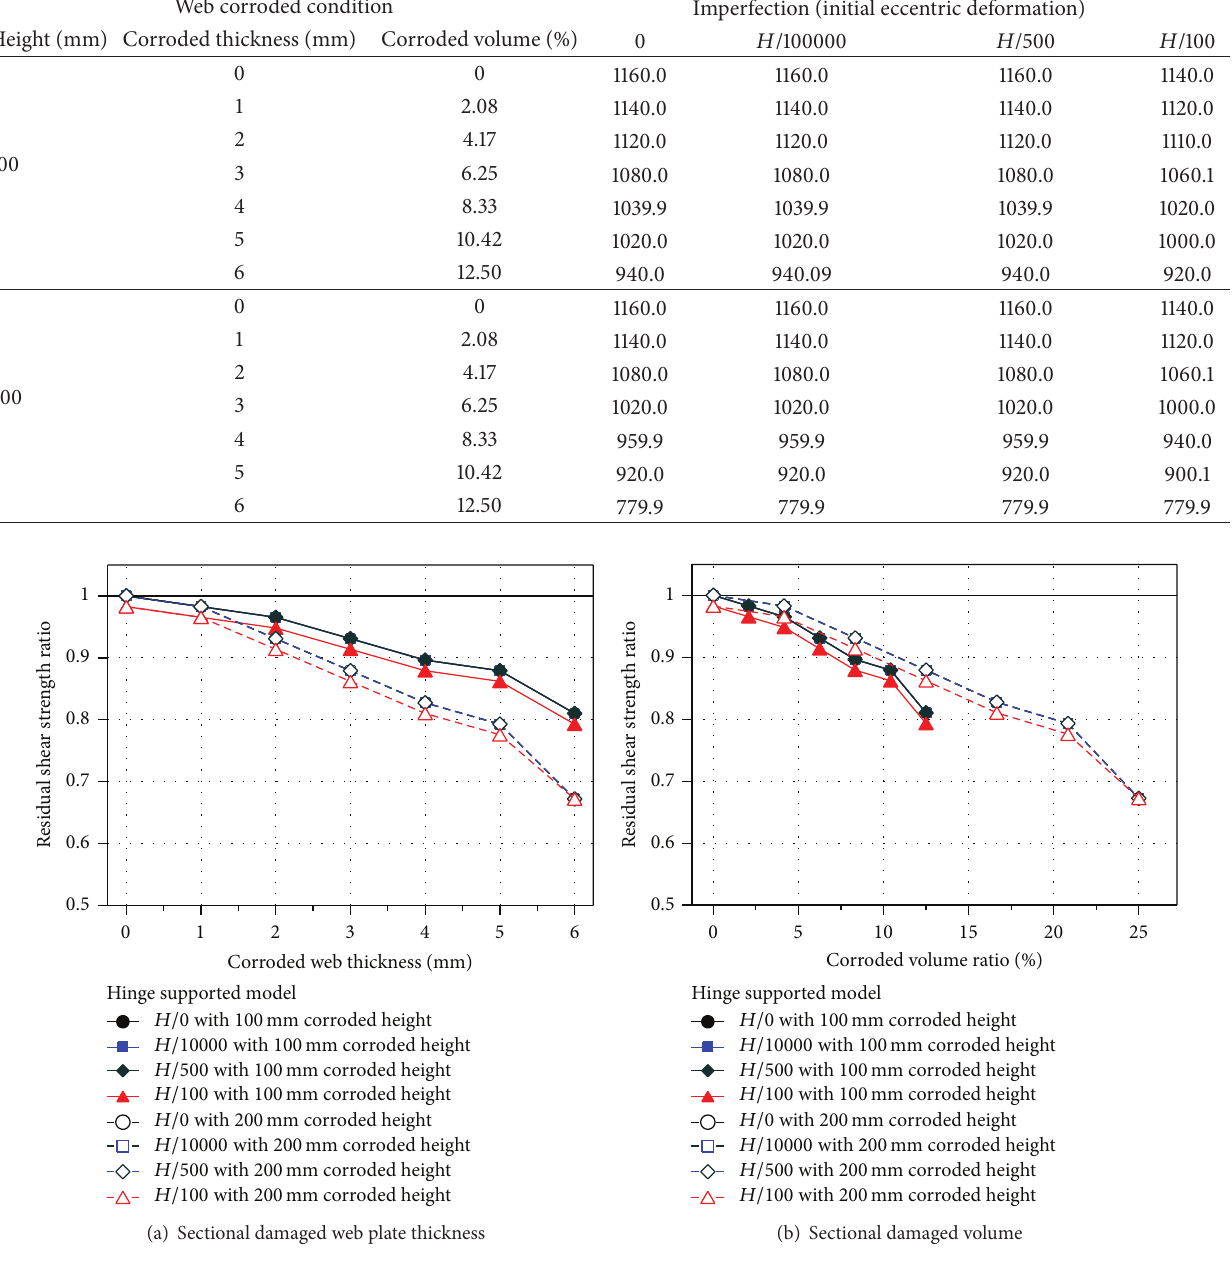
Figure 7: Shear buckling resistance ratios with hinge